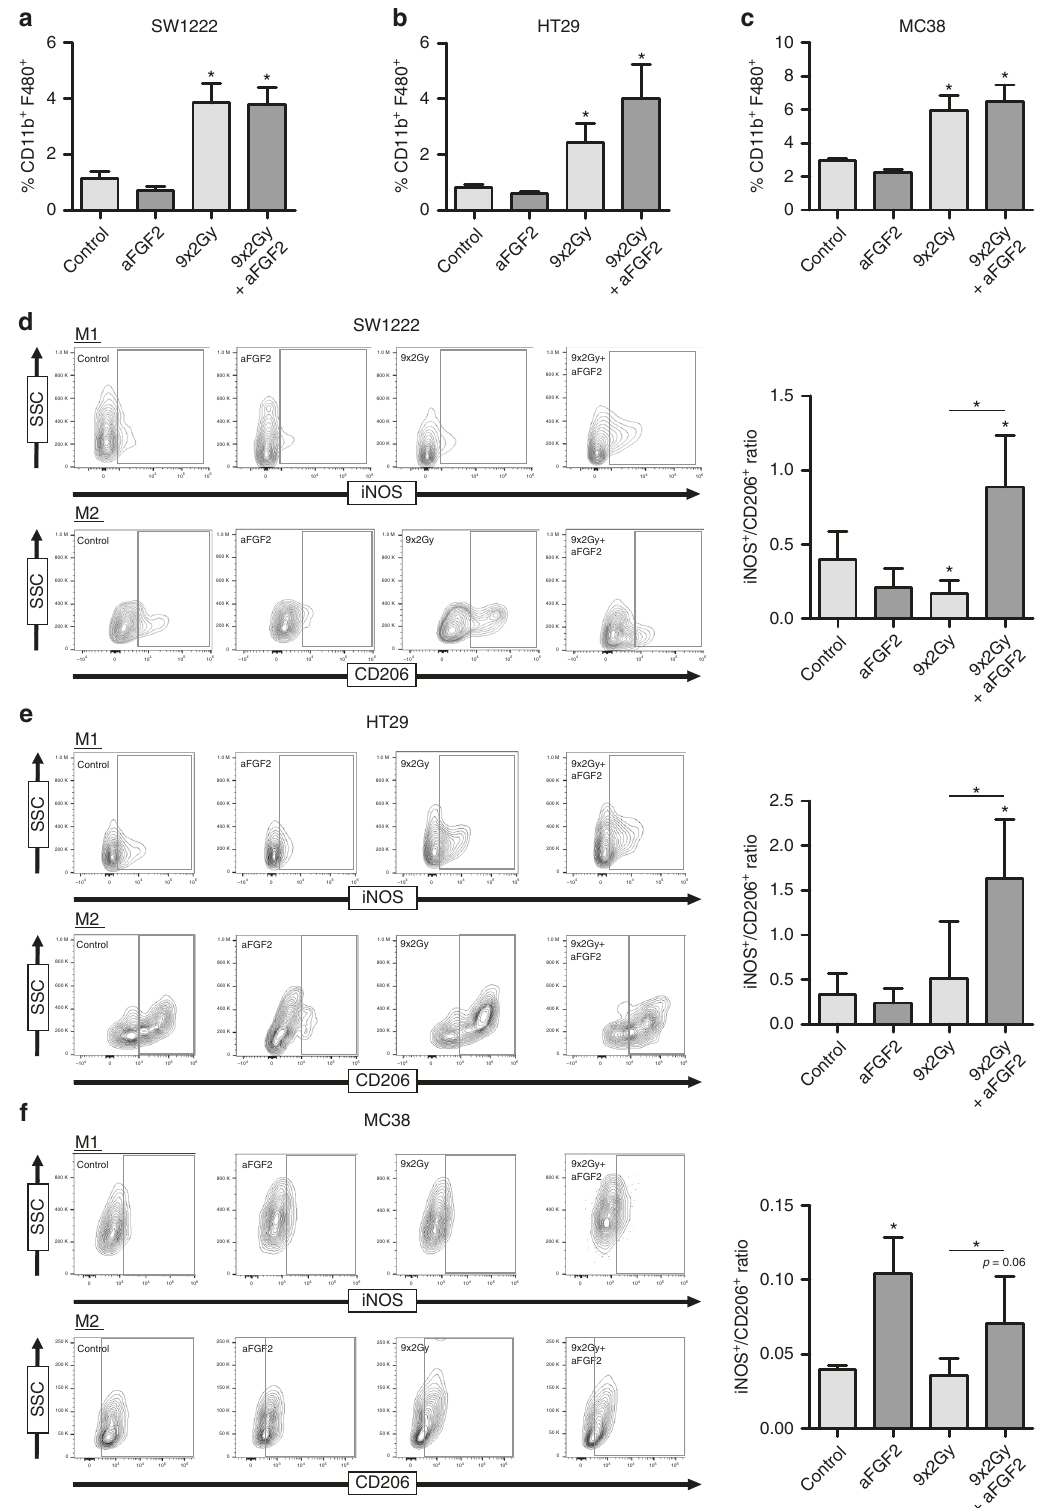
Fig. 8 Macrophage recruitment and polarisation following irradiation and anti-FGF2 combination therapy. Macrophage recruitment following anti-FGF2, irradiation or combination therapy for ( a ) SW1222, ( b ) HT29, and ( c ) MC38. Macrophage iNOS and CD206 expression following anti-FGF2, irradiation or combination therapy for ( d ) SW1222, ( e ) HT29, and ( f ) MC38. N is shown at Supplementary Fig. 5E. * represents statistical signi fi cance compared with control mice ( p ≤ 0.05). Error bars indicate